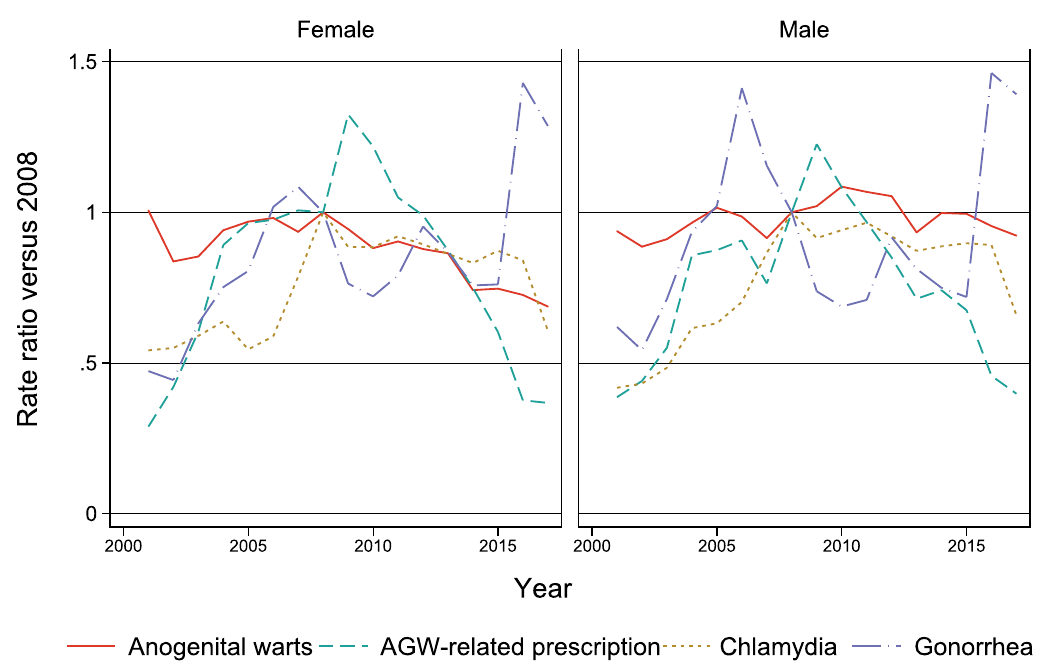
Fig 1. Age-standardized incidence rate ratios of conditions of interest (indexed to the 2008 introduction of the school-based qHPV vaccination program) by year and gender.